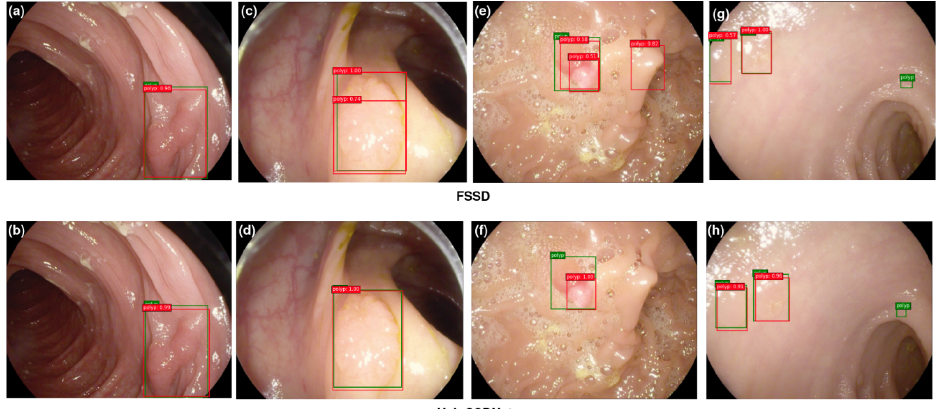
Figure 13. Qualitative results comparison between FSSD300 ( a , c , e , g ) and the proposed Hyb-SSDNet ( b , d , f , h ) on the ETIS-Larib polyp test set. True bounding boxes with IoU of 0.5 or higher with the bounding predicted boxes are drawn in green and red colors,